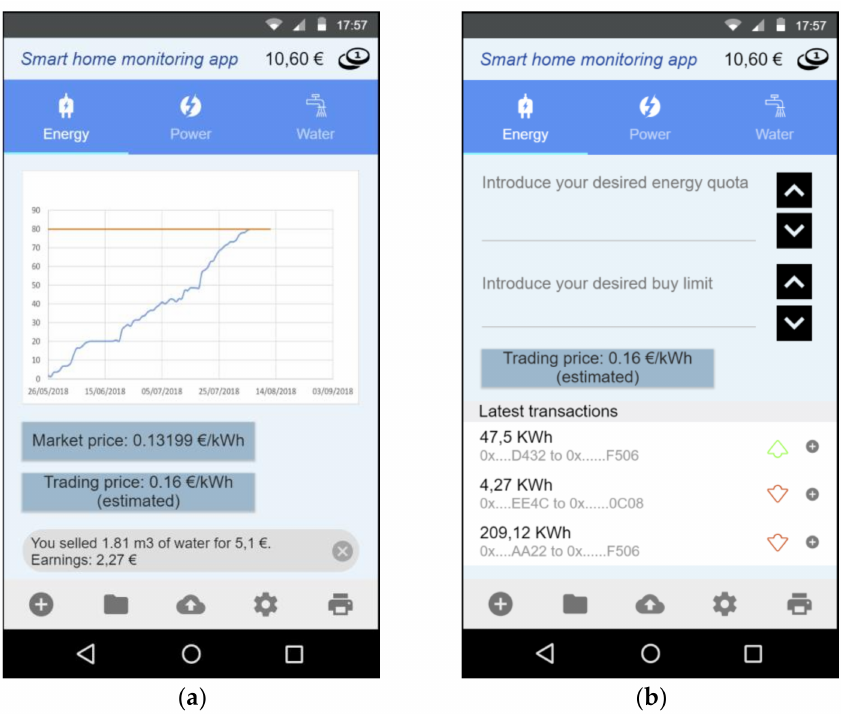
Figure 8. Implementation prototype: ( a ) energy main tab energy; ( b ) transaction